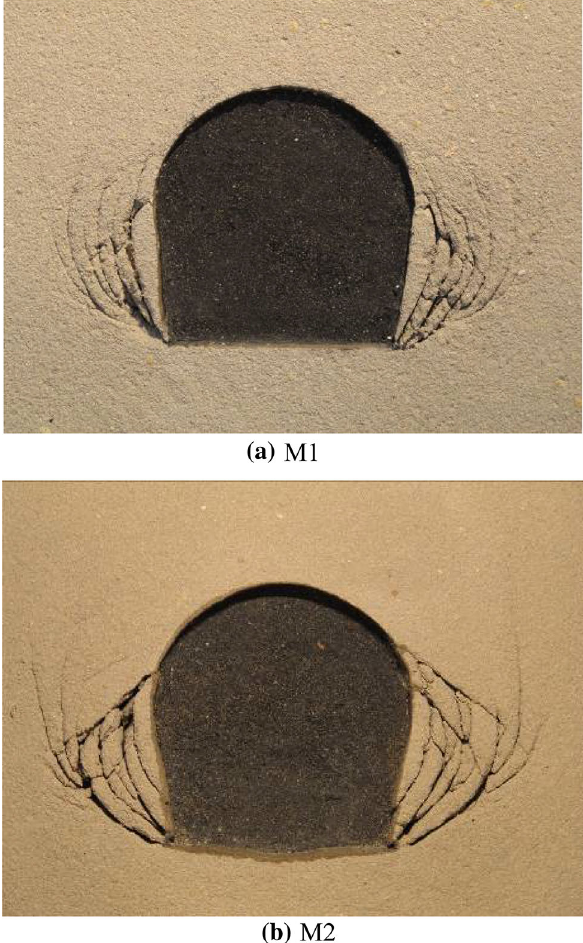
Fig. 3 Comparison of loads for the a M1, b M2, and c M3 model tunnels